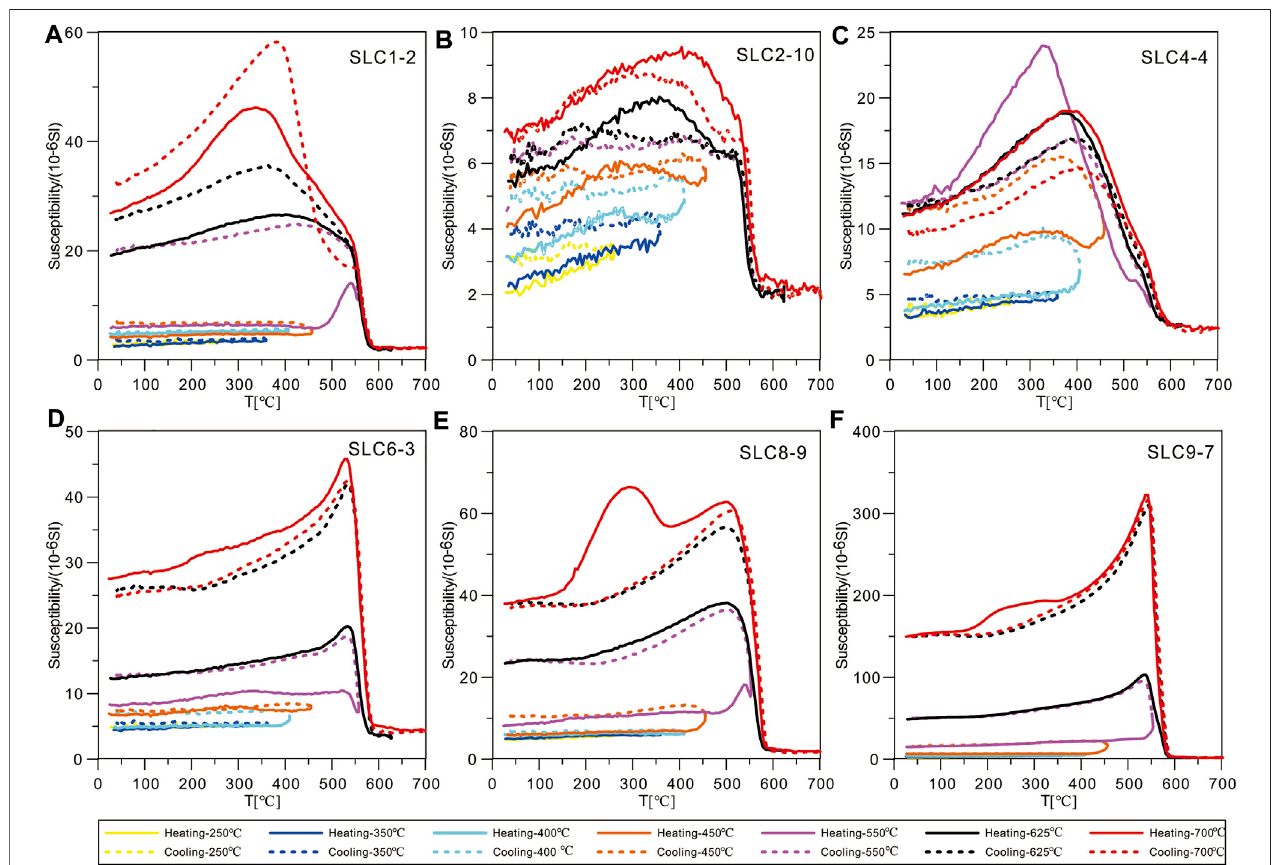
FIGURE 5 | (A-F) Multicycle high-temperature magnetic susceptibility curves of the representative samples.